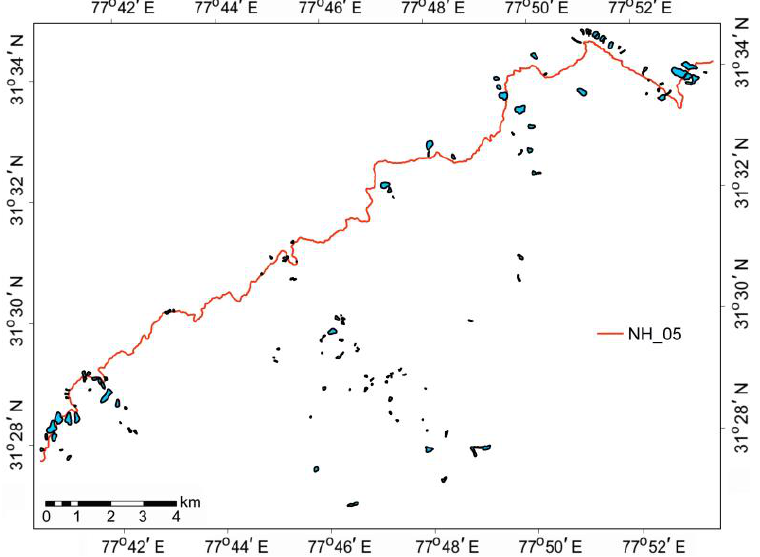
Figure 11. Landslide inventory of the study area. Each landslide in the area is outlined in a black line and filled with cyan colour. The red line represents the national highway 05 that passes through the study region.